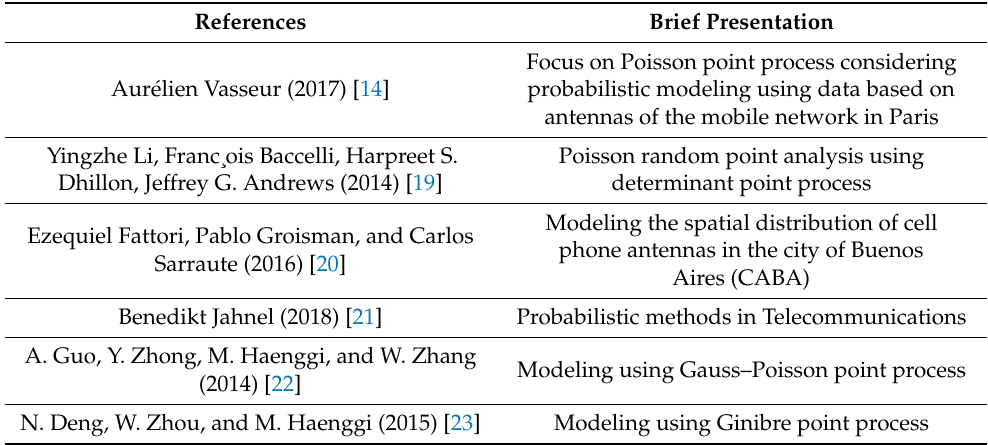
Table 1. Presentation of previous research into random point process involving antenna stations for